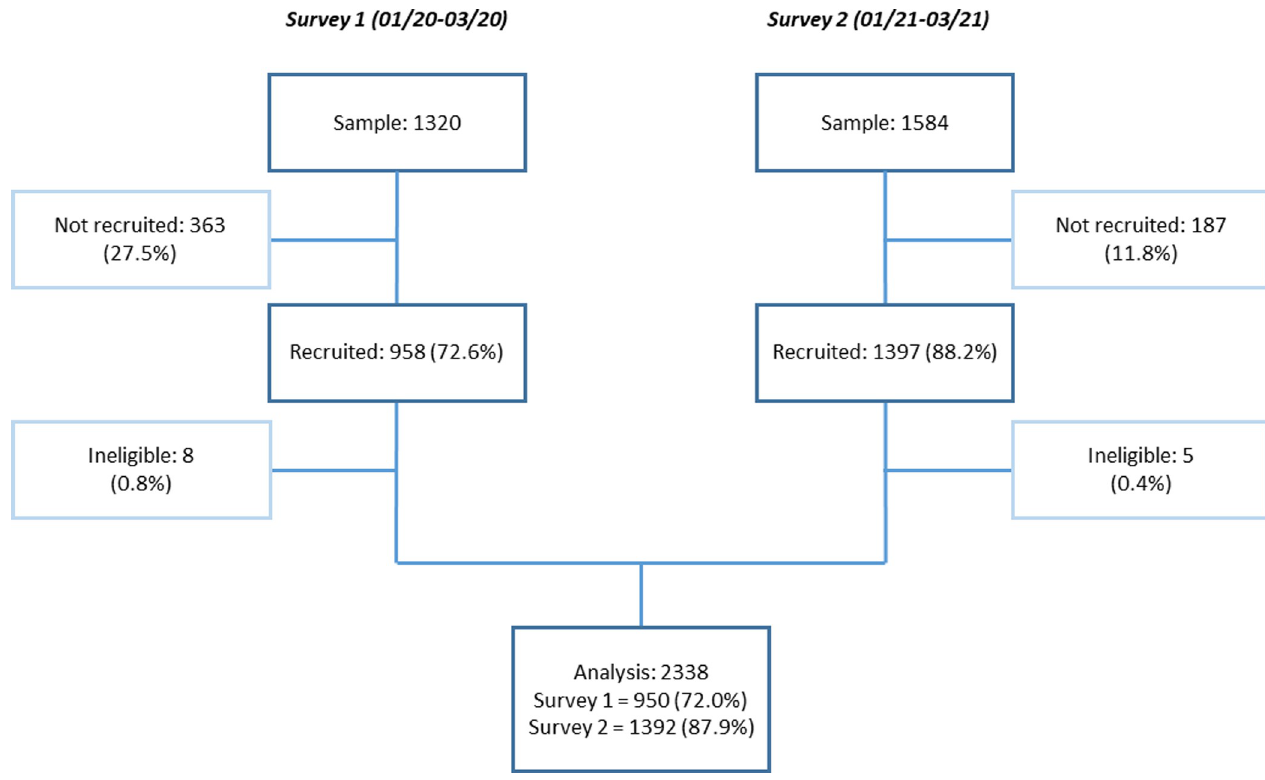
Fig 1. Participant recruitment